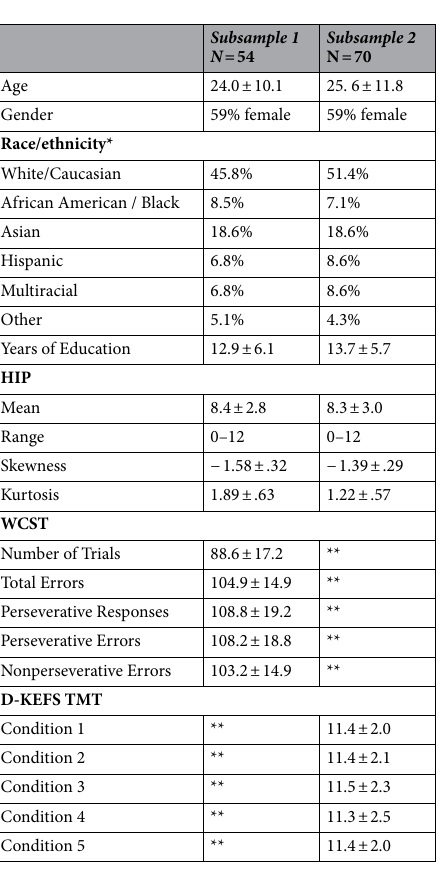
Table 1. Demographics. D‑KEFS Delis–Kaplan Executive Function System, HIP Hypnotic Induction Profile, TMT Trail Making Test, WCST Wisconsin Card Sorting Test. *Five participants did not check any race/ ethnicity. **Was not analyzed in this